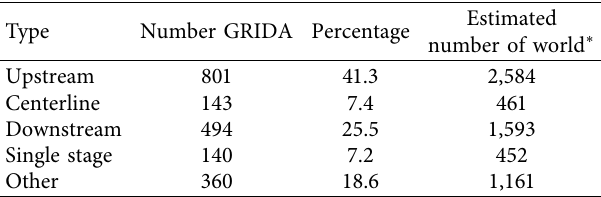
Table 2: Estimation of world tailings dams by